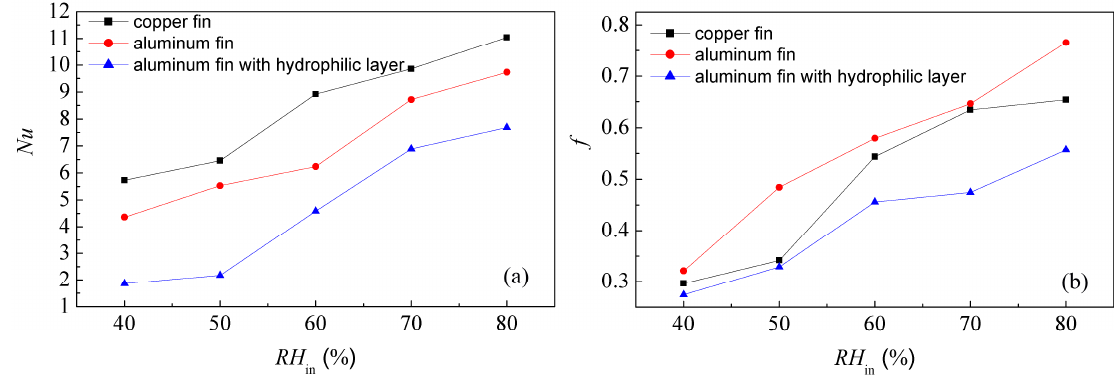
Figure 12. Effect of RH in on Nu and f : ( a ) Nu , ( b ) f .